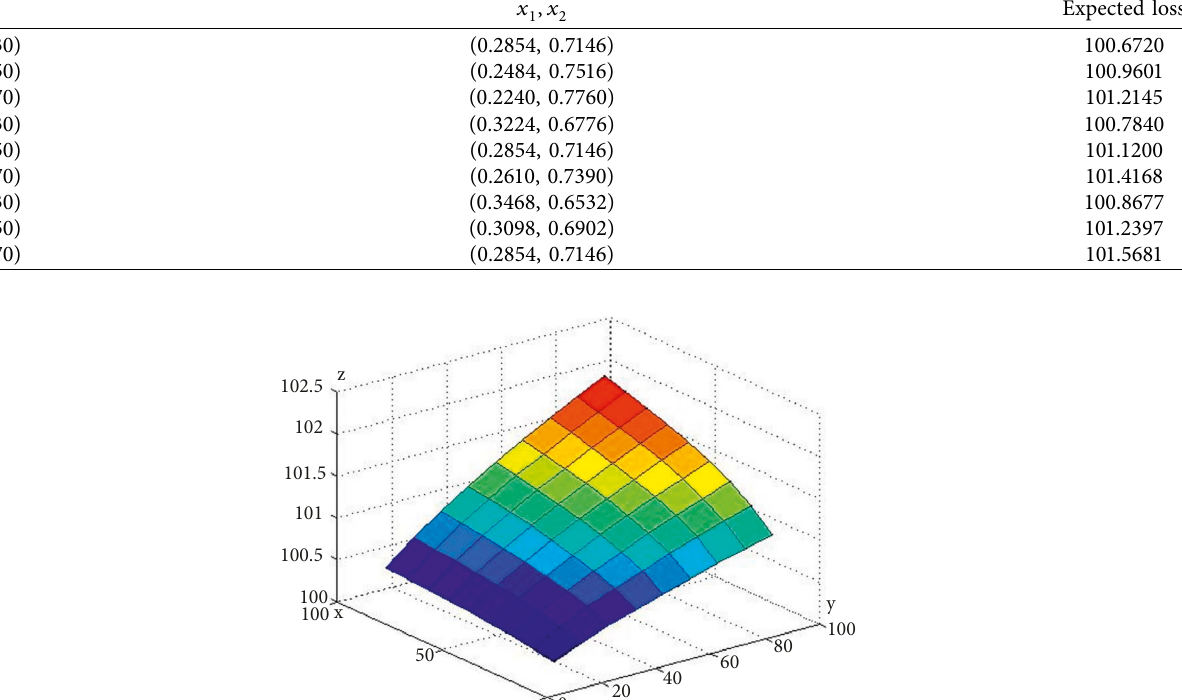
Table 3: The influences of L